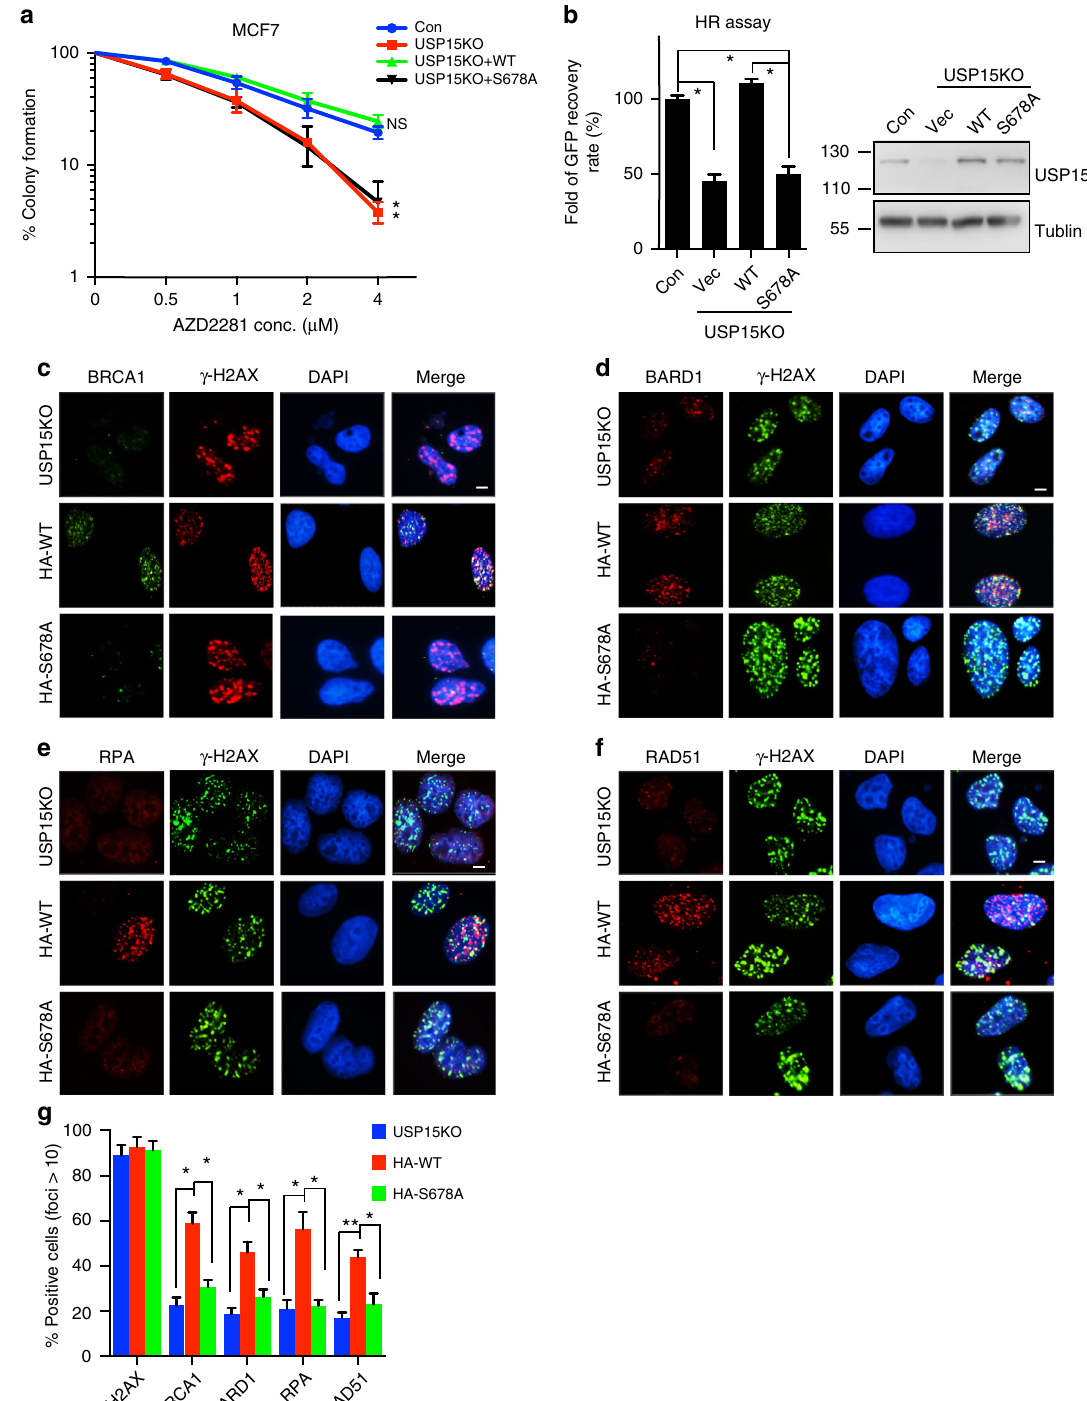
Fig. 5 USP15 Ser678 phosphorylation is essential for its function in homologous recombination (HR). a USP15-depleted MCF7 cells were reconstituted with USP15 wild-type (WT) or S678A mutant. Cells ’ response to poly-(ADP-ribose) polymerase (PARP) inhibitor (AZD2281) were analyzed by colony formation assay. Data are presented as mean±SEM of three independent experiments, two-way analysis of variance (ANOVA), * P < 0.05. b USP15- knockout U2OS direct repeat green fl uorescent protein (DR-GFP) cells were reconstituted with HA-USP15 WT or S678A mutant and HR ef fi ciency were determined. Data are presented as mean±SD of three independent experiments. Two-tailed Student's t test, * P < 0.01. c – g USP15-knockout U2OS cells reconstituted with USP15 WT or S678A mutants were irradiated (4Gy), and 3 h later, BRCA1 foci ( c ), BARD1 foci ( d ), RPA foci ( e ), and RAD51 foci ( f ) are examined by indicated antibodies. Quanti fi cation ( g ) were average of three independent experiments, and 100 cells were counted for each experiment. Data are presented as mean ± SD, two-tailed Student's t test, * P < 0.05, ** P < 0.01. Scale bar: 10 μ m. Unprocessed scans of blots are provided